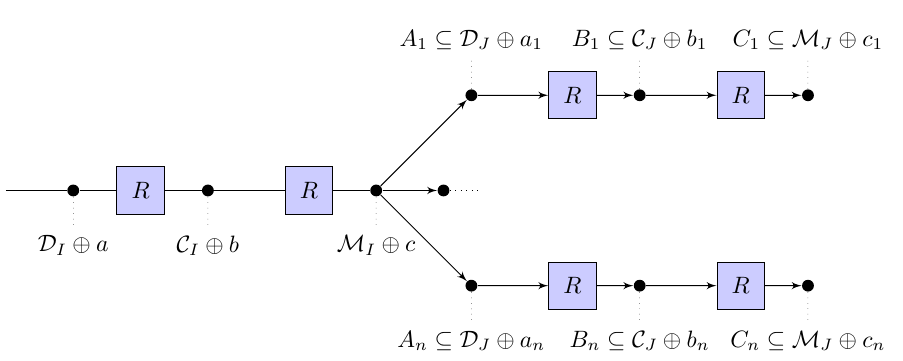
Figure 7: 4-round distinguishers for AES (where the index n is defined as n := (2 8 ) 4 | I | and the indexes I and J satisfy the condition 0 < | I | + | J | ≤ 4).